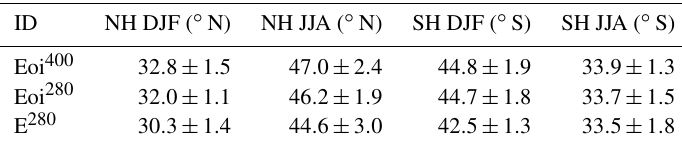
Figure 6. Mean annual and seasonal Pliocene precipitation anomalies. (a) Annual Eoi 280 –E 280 , (b) annual Eoi 400 –E 280 , (c) JJA Eoi 280 – E 280 , (d) JJA Eoi 400 –E 280 , (e) DJF Eoi 280 –E 280 and (f) DJF Eoi 400 –E 280 . Stippling indicates regions in which results are not statistically significant at a 95% confidence criterion. Table 5. Climatological zonal mean core latitude of the subtropical jet (StJ) for E 280 , Eoi 280 and Eoi 400 experiments during December– January–February (DJF) and June–July–August (JJA) seasons. Note that only the StJ is reported as it is more stable and persistent than the polar